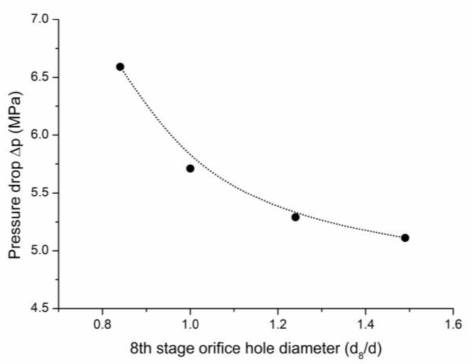
Figure 21. Pressure drop depending on the size of the hole diameter in the eighth stage